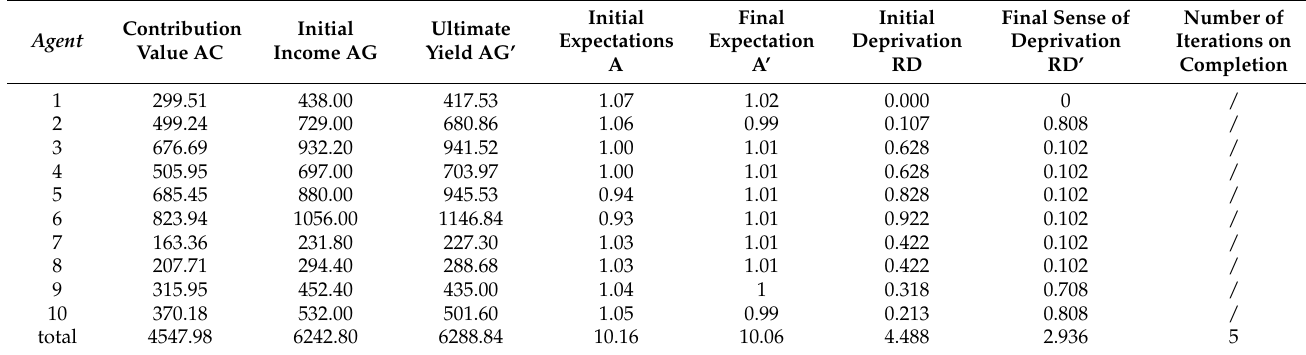
Table 7. Profit distribution results for σ =